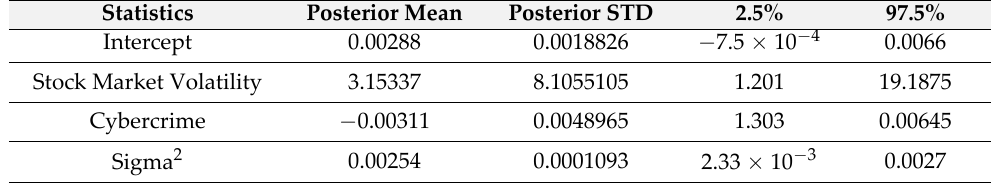
Table 4. BLR results with Return on Ethereum as dependent